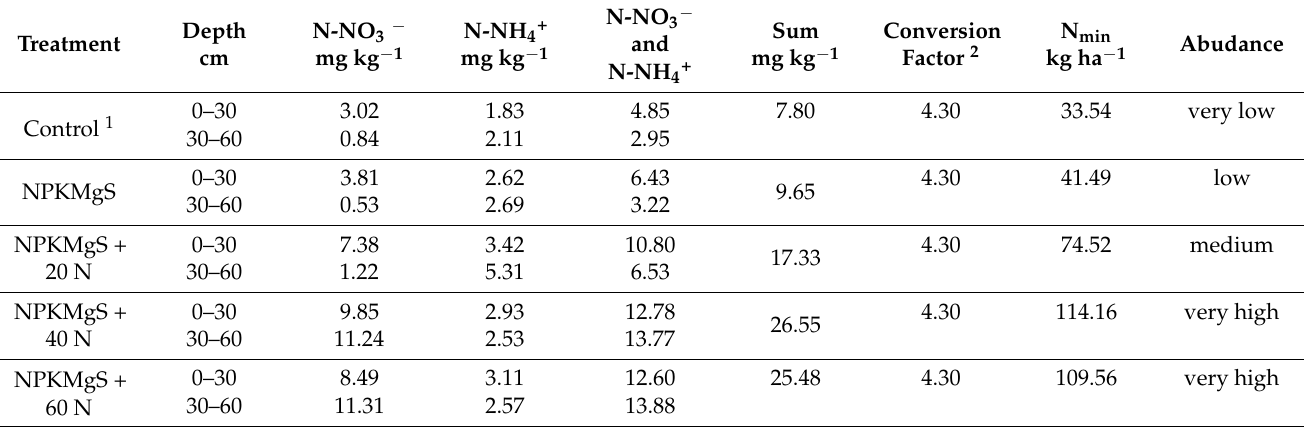
Table 2. Mineral nitrogen in soil (3-year